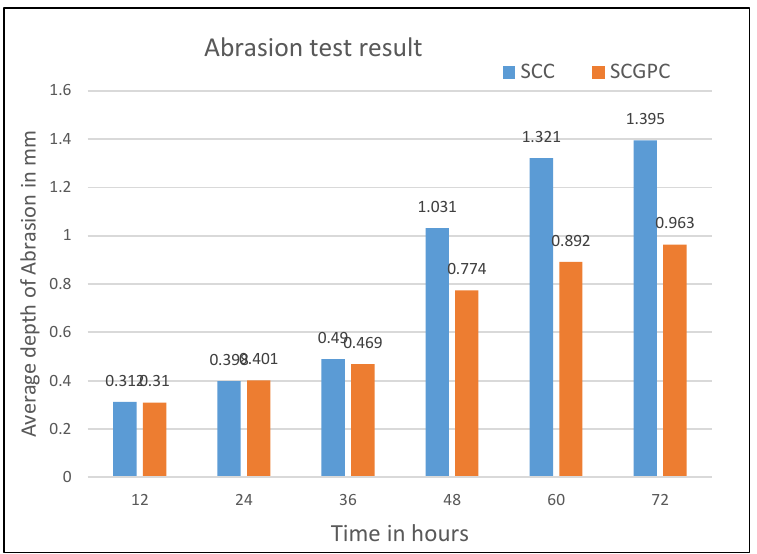
Fig. 14. Graph showing the variation of Depth of abrasion vs